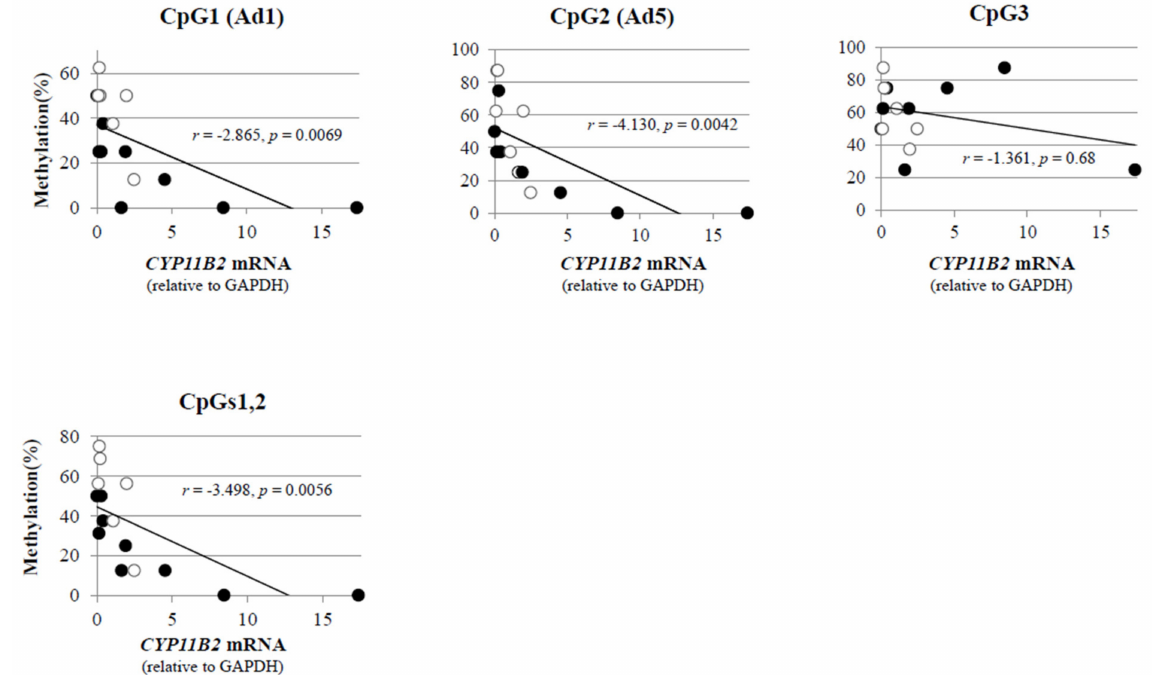
Figure 7. Inverse correlation between the CpG methylation ratios and the CYP11B2 mRNA levels. Statistically significant nonparametric inverse correlations were observed between the CpG methylation ratio and the CYP11B2 mRNA level. The CpG methylation at CpGs 1 and 2, but not CpG3, was inversely correlated with the CYP11B2 mRNA levels in the